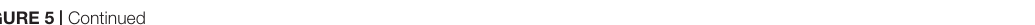
TABLE 2 | Common characteristics of high and low-moderate scored organizations. Relatively high scoring organizations NEAFC, NAFO, CCAMLR, SEAFO